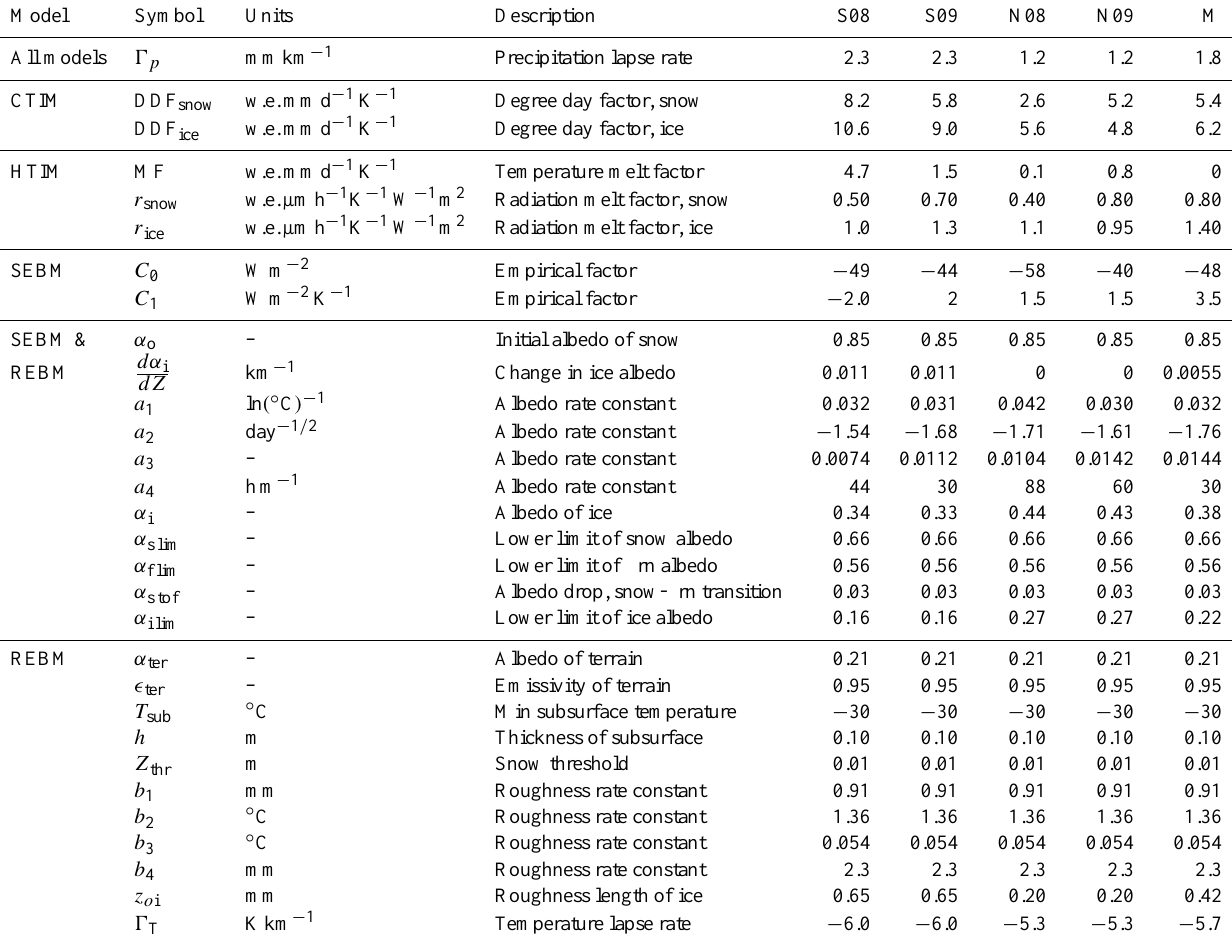
Table 3. Parameters used for or derived in the control runs where melt models are tuned to real data for South Glacier (S) and North Glacier (N) for 2008 (08) and 2009 (09). In the master control run (M) data from both glaciers in both years are used together to derive model